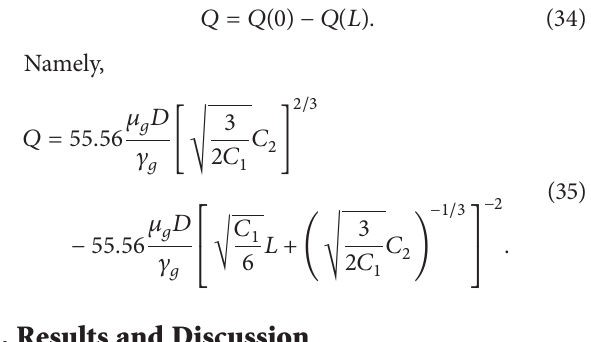
= 20 MPa, 𝑤𝑓 = 0.1 mD, 𝑎 = 𝑑ℎ V . max